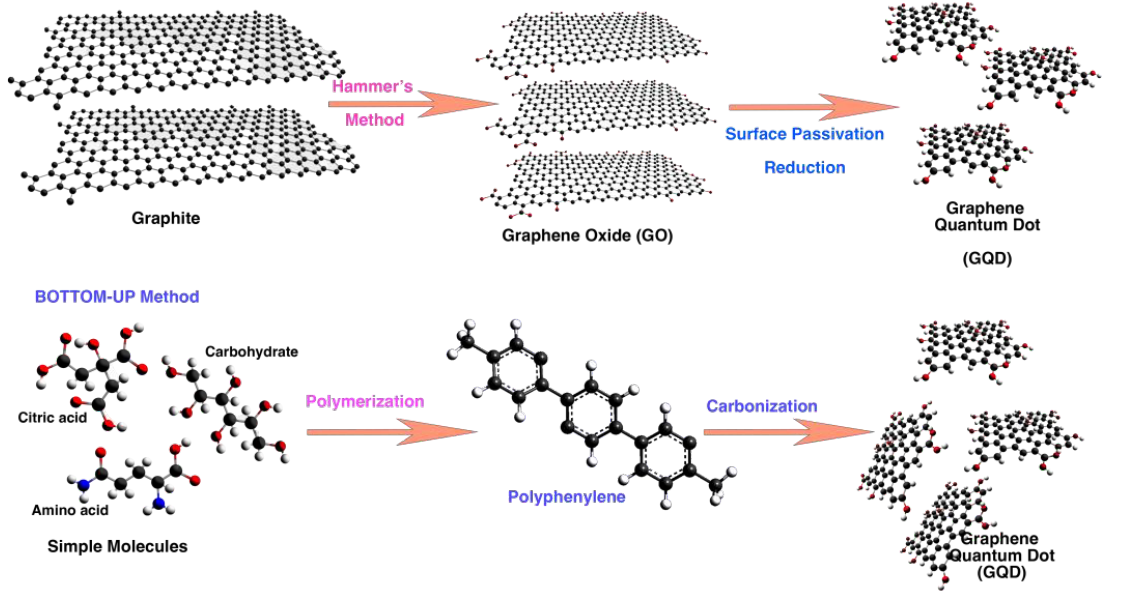
Figure 2. Schematic diagram representing the top-down and bottom-up approaches for the synthesis of GQDs.